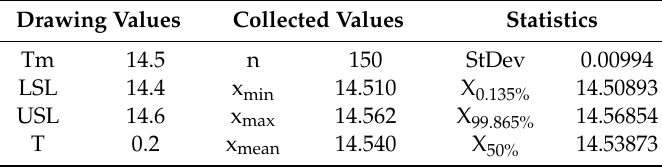
Table 8. Process capability analysis for the D